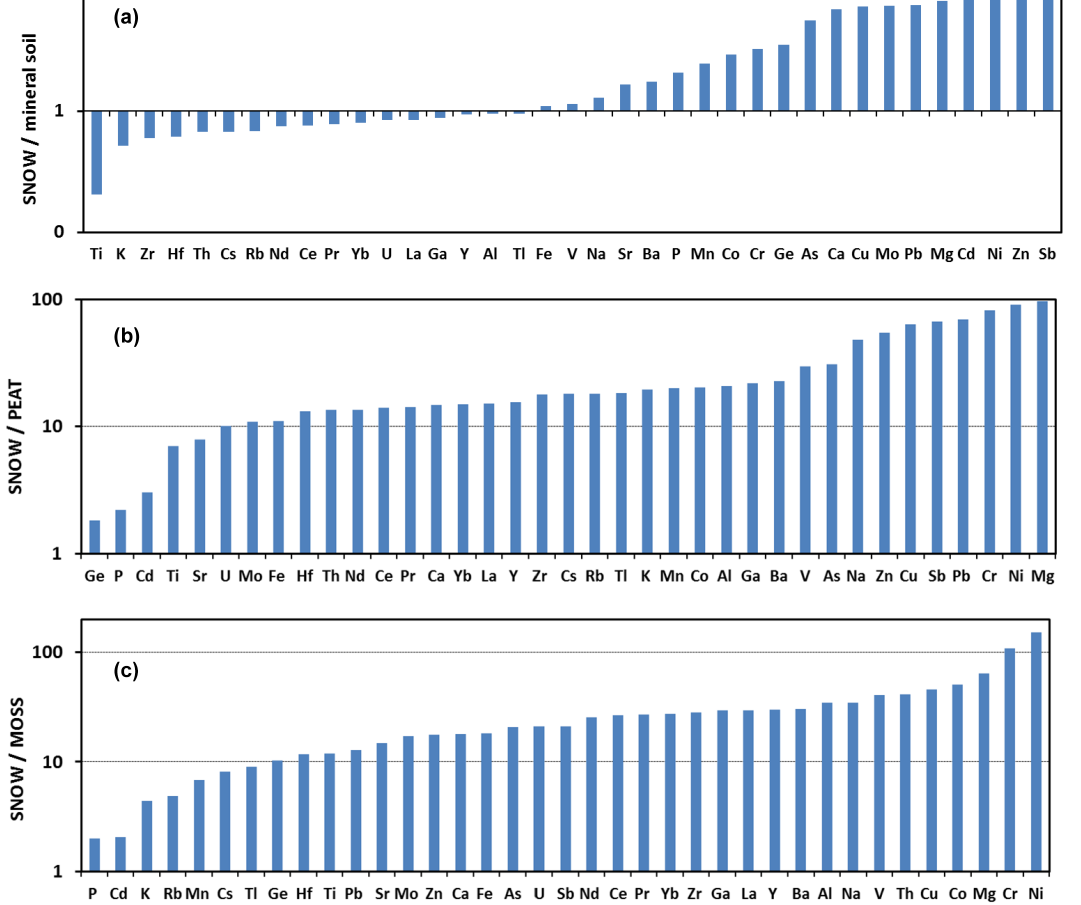
Figure 6. The ratios of the average concentrations of elements in snow particles (neglecting sample SF22) to those in mineral soil (a) , peat (b) and mosses (c) of the WSL. The peat, moss, and underlying mineral horizons data are averaged over the latitude of 55 to 68 ◦ N as described in Stepanova et al. (2015). Note normal Y scale for mineral soil (a) and log Y scale for peat and moss (b, c)